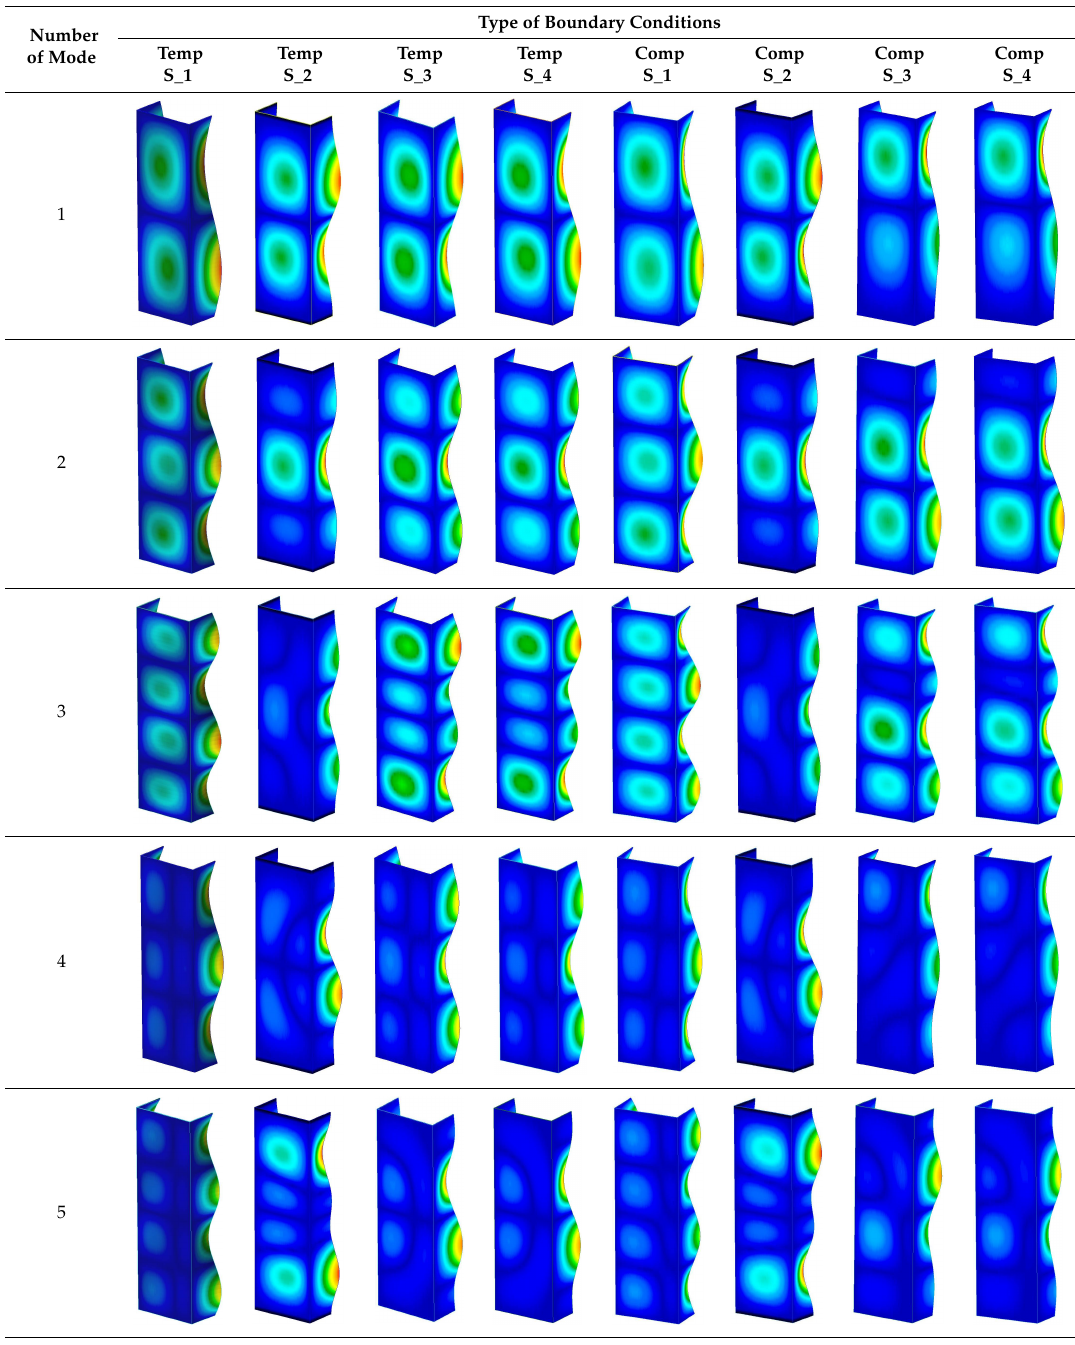
Table 2. The buckling modes of the columns.